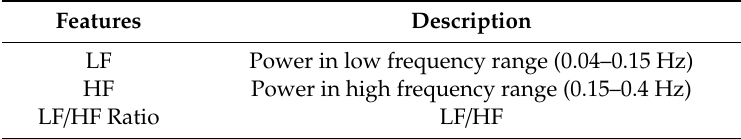
Table 1. Frequency-domain Heart Rate Variability (HRV) parameters